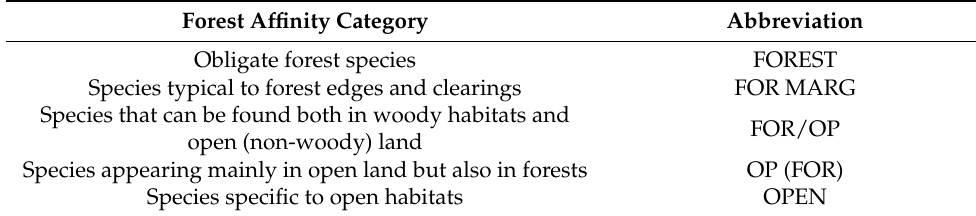
Table 2. Forest affinity categories and their abbreviations in the